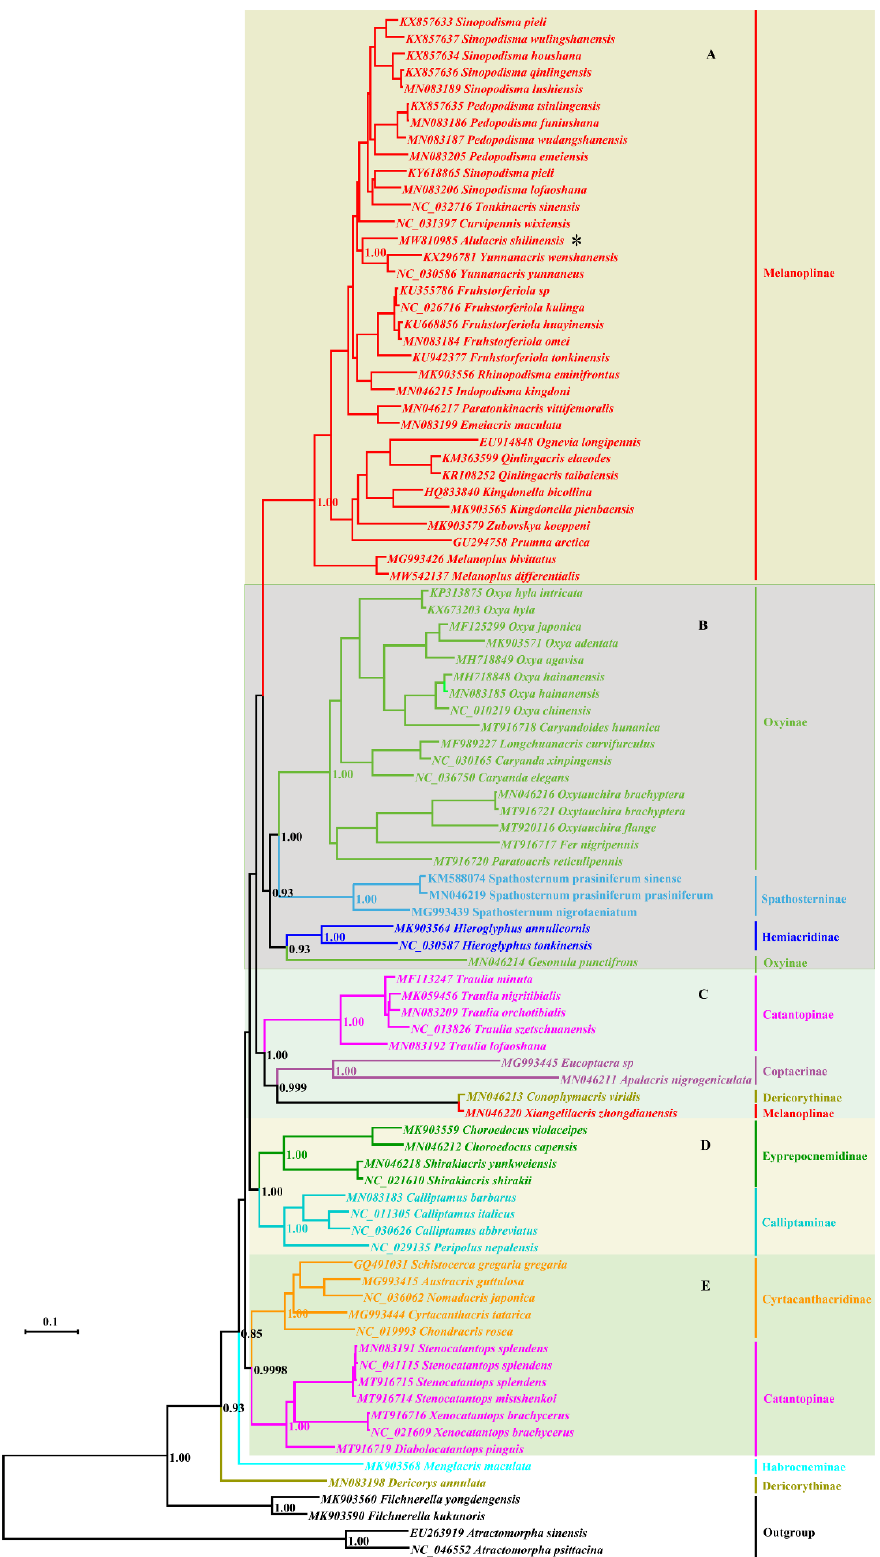
Figure 3. Phylogenetic tree reconstructed from sequences of the 13 mitogenome PCGs (protein-coding genes) using Bayesian inference. The asterisk indicates the species Alulacris shilinensis . ( A ). Melanoplinae (excluding the genus Xiangelilacris ). ( B ). Oxyinae+Spathosterninae+Hemiacridinae. ( C ). Coptacrinae+ Traulia + Conophymacris + Xiangelilacris . ( D ). Eyprepocnemidinae+Calliptaminae. ( E ). Cyrtacanthacridinae+Catantopinae.